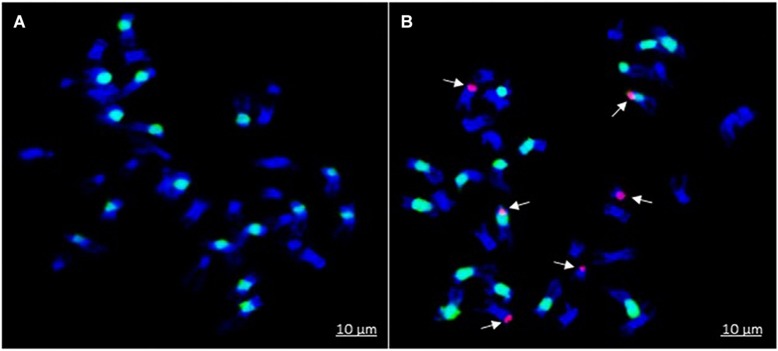
Genomic in situ hybridization on mitotic spreads of B. juncea–E. cardaminoides introgression lines (ILs). B. nigra B genome is painted in green (labeled with fluorescein-12-dUTP dye) while E. cardaminoides introgressions are shown in red color (labeled with rhodamine-5-dUTP dye): (A)
B. juncea with no introgression; and (B) IL with segment substitutions in two chromosome pairs of A-genome and one chromosome pair of B genome.